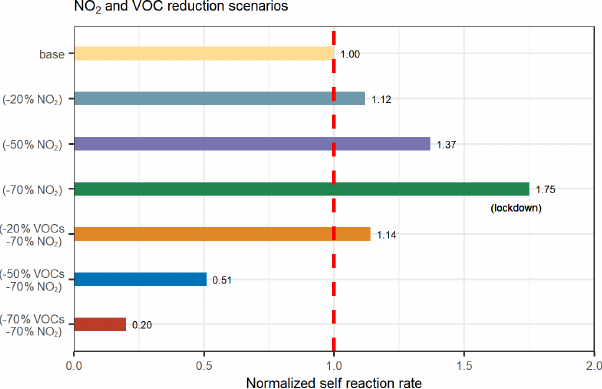
Figure 6. Changes in the self-reaction rate between peroxy radicals with 20%–70% reduction in NO 2 and a further 20%–70% reduc- tion in VOC. The COVID-19 lockdown in 2020 corresponded to a reduction in NO 2 of 70%. The reaction rate in different reduction scenarios was normalized to the value in the base run (guided by the dashed red